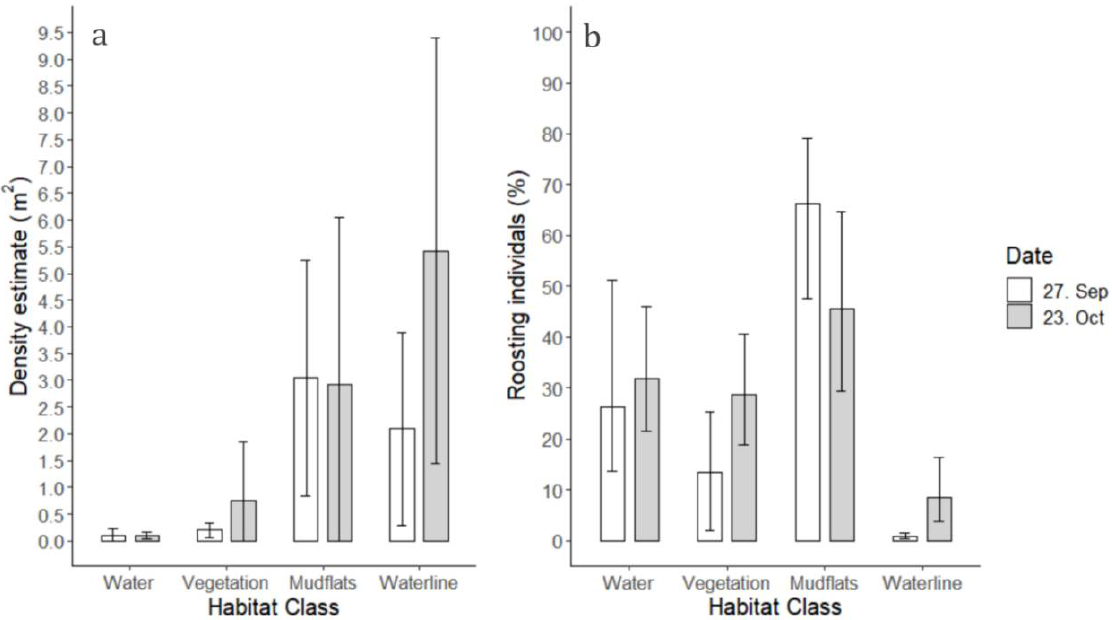
Figure 8. Habitat selection of high-tide roosting waterbirds in the investigated area. The available habitats on the roost site were categorized in four classes: Water, Vegetation, Mudflats and Waterline. Observations from both field days (27 September and 23 October) were differentiated in the analysis. The habitat selection was explored in two ways: ( a ) all identified individuals were pooled per flock and densities were calculated for each corresponding habitat class, and ( b ) the percentage of roosting individuals was first calculated for each species and then pooled, thereby securing an equal weighting among the 10 investigated species for each habitat class. Error bars are ( a ) represented by standard deviations (SD) of the mean and ( b ) by bootstrapped 95% confidence intervals (CIs) of the